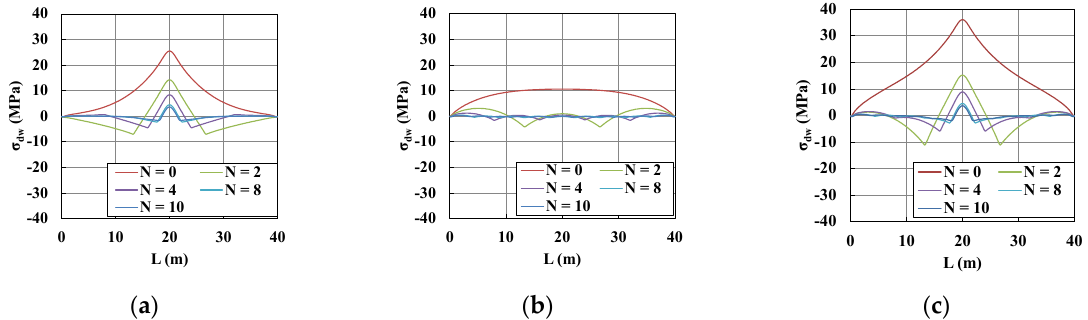
Figure 9. Distortional warping normal stress distributions of a bridge model with span of 40 m and H/B of 0.7 along the span when LC1 was applied. ( a ) Concentrated load (truck load), ( b ) distributed load (lane load), and ( c ) combined design truck and lane load.